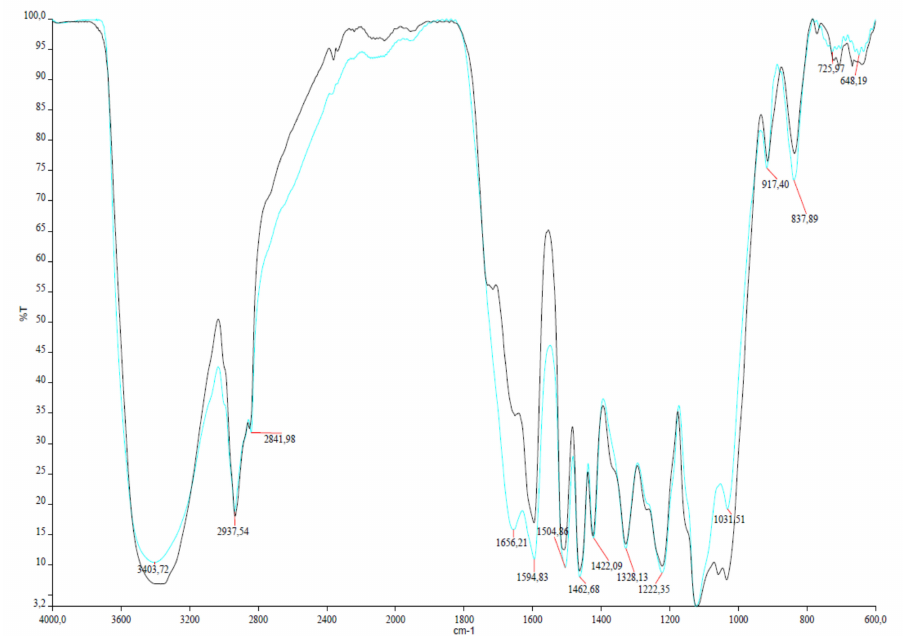
Figure 6. FT-IR spectra of ScLac-treated (blue) and nontreated (black)